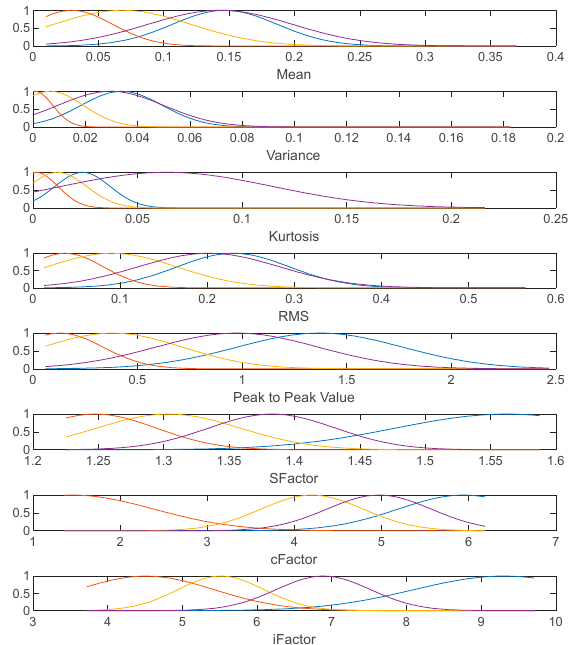
Figure 8. Membership functions for the statistical features using FCM.